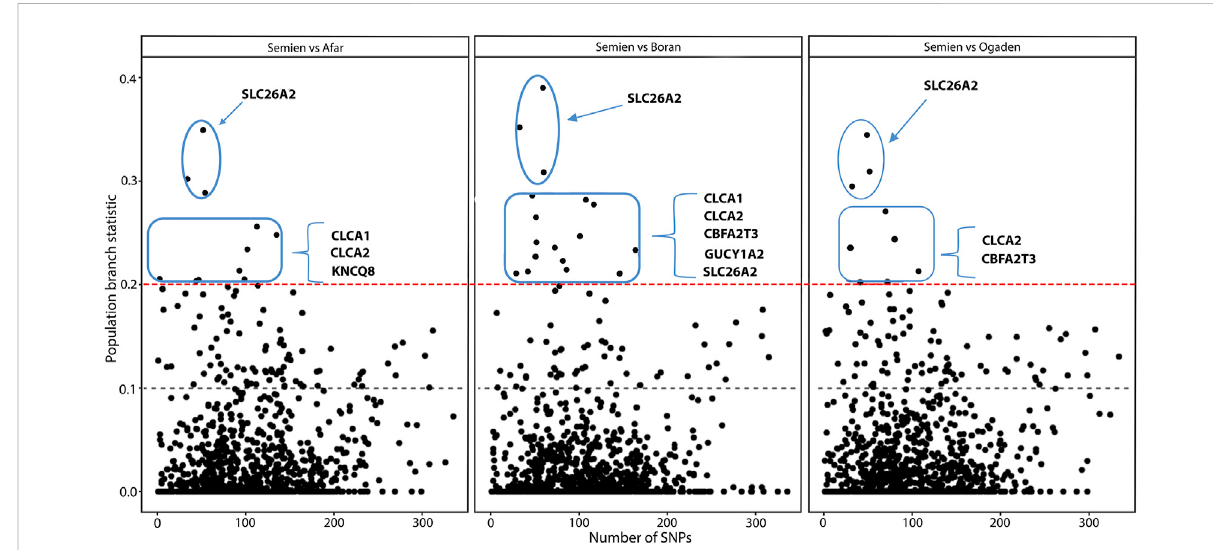
FIGURE 6 The distribution of the population branch statistic (PBS) values in 10 kb genomic regions as a function of the number of SNPs.